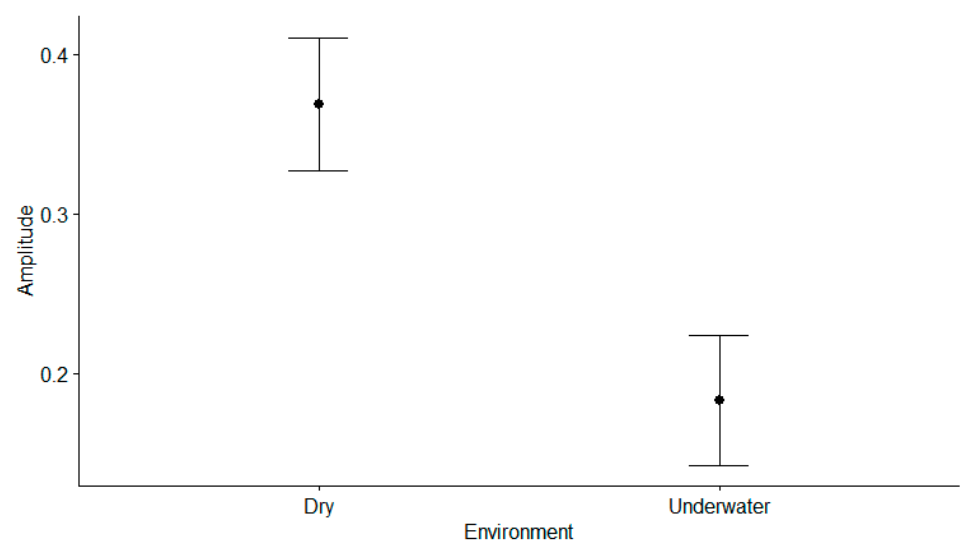
Figure 8. Amplitude plot: left plot shows the amplitude of the dry environment from NeXus-10 MKII and right plot shows the amplitude of underwater environment from Samsung Galaxy Note8.